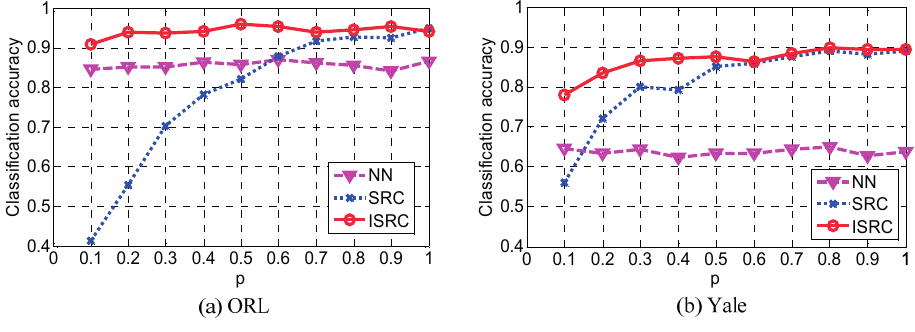
Figure 2. Classification performance comparisons among NN, SRC and